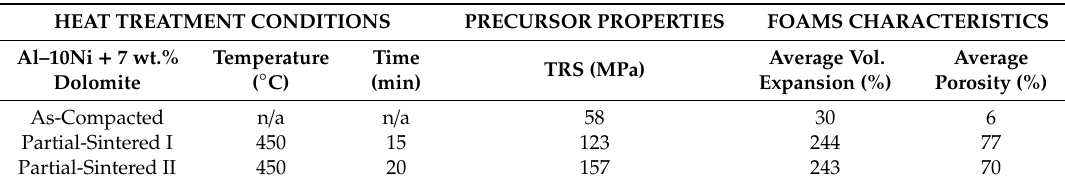
Table 2. Transverse rupture strength (TRS) data of as-compacted and partial sintered (Al–10Ni) with 7 wt.% dolomite and the characteristics of the resulted foams.